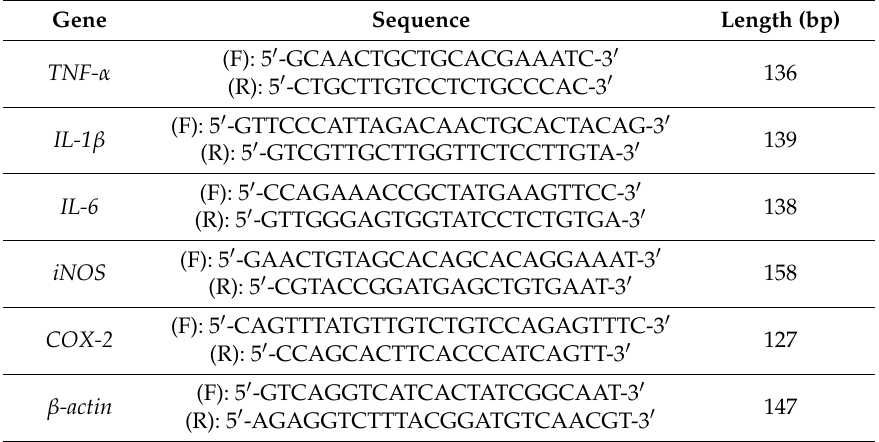
Table 1. The primer sequences of TNF- α , IL-1 β , IL-6 , iNOS , COX-2 , and β -actin